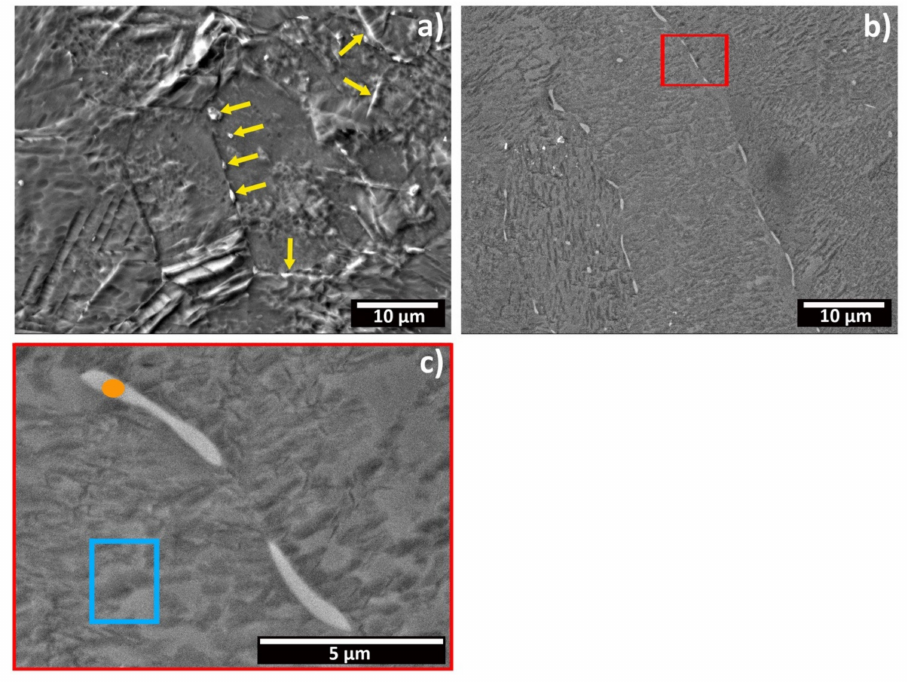
Figure 2. FESEM micrographs of the bare CP-Ti sample: ( a ) SE micrograph of a sample etched in Kroll’s solution for 30 s, ( b ) backscattered electrons of a polished sample, and ( c ) detail of figure ( b ) (red